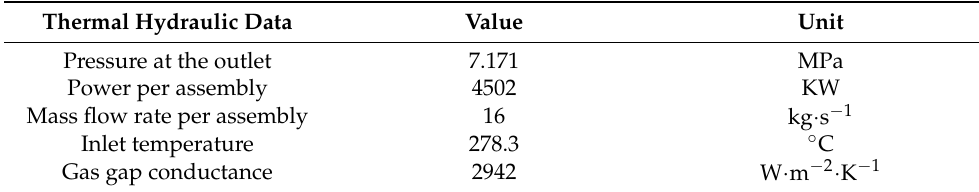
Table A1. Thermal hydraulic data used within the model.